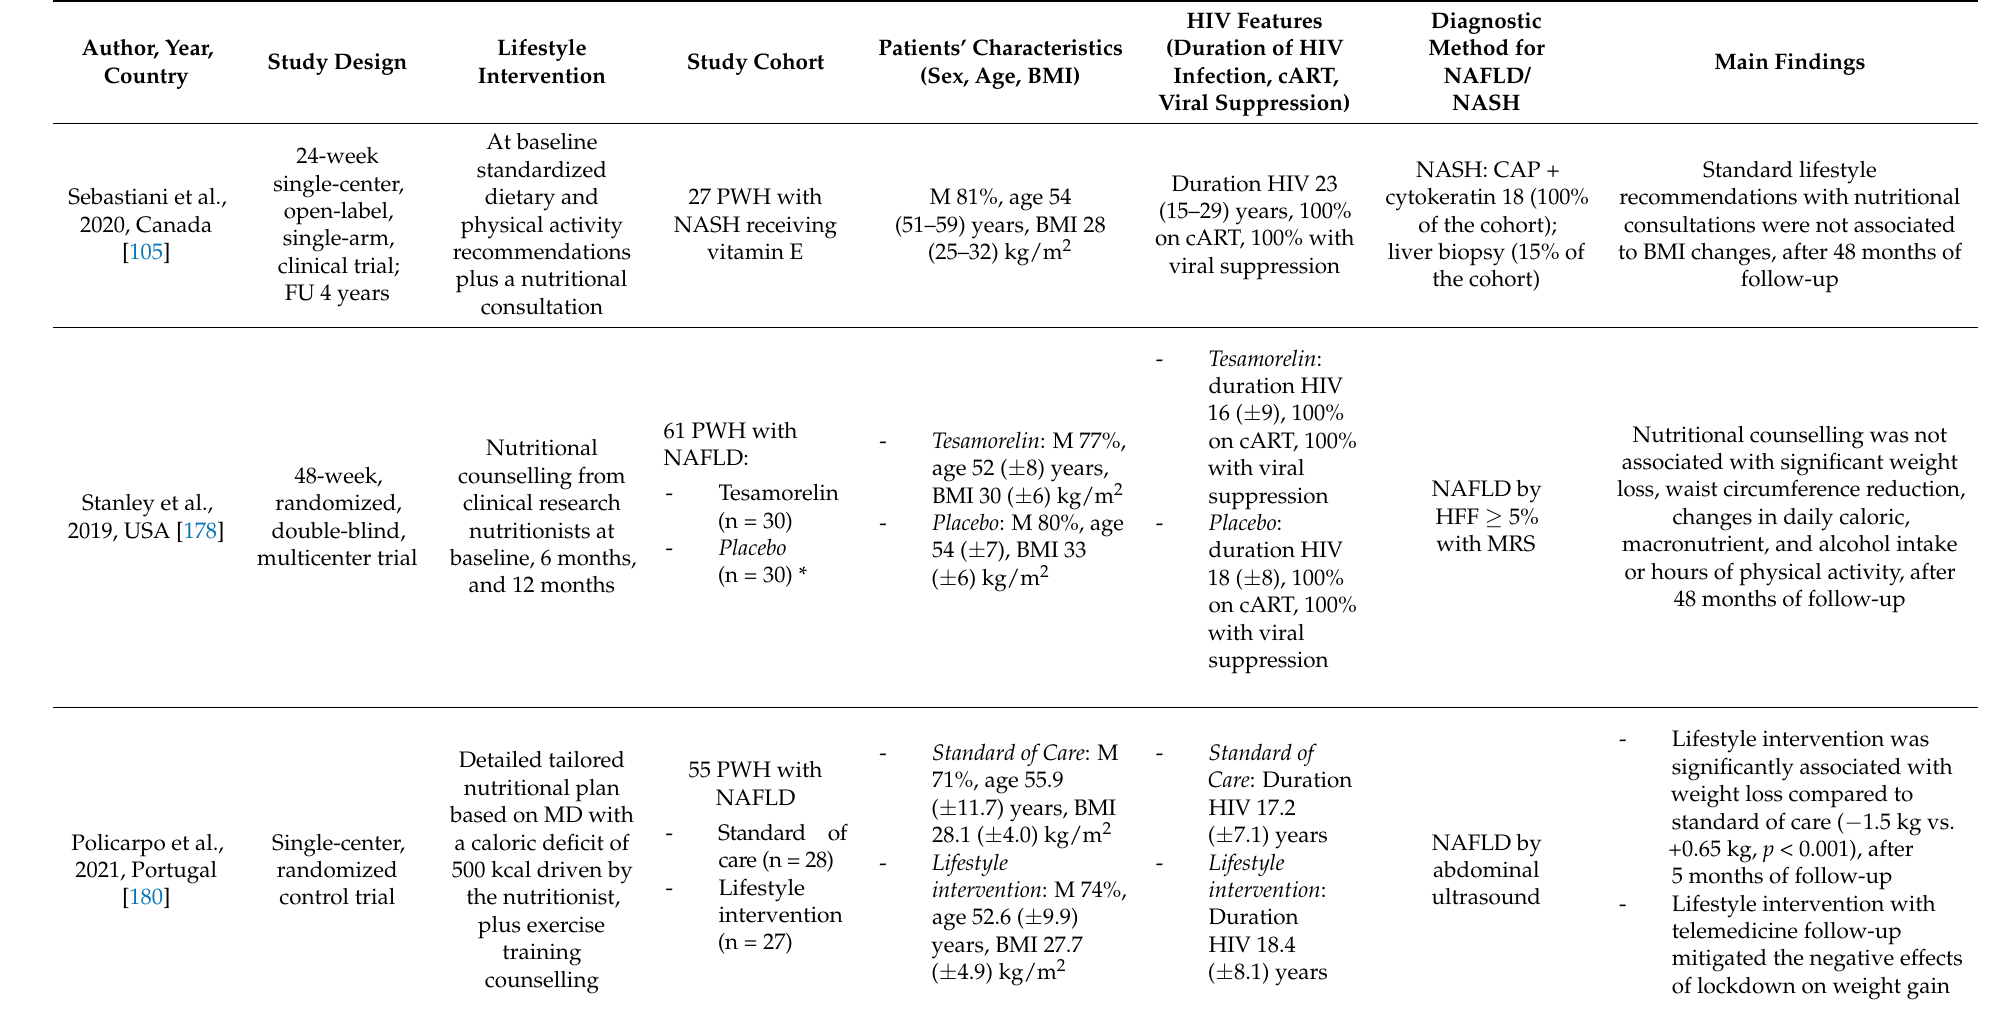
Table 3. Studies evaluating the role of lifestyle intervention in weight loss in hepatic steatosis in people with